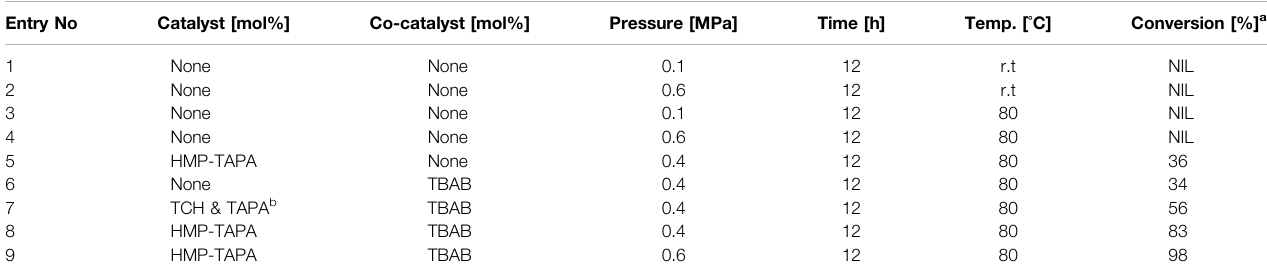
TABLE 1 | Optimization of reaction conditions for cycloaddition of CO 2 with styrene oxide catalyzed by